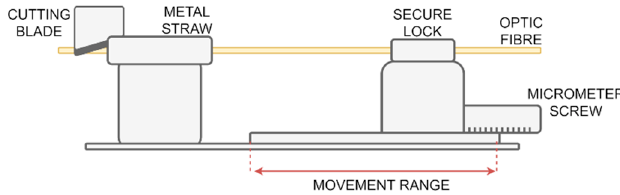
Figure 7. Experimental setup of the wearing simulation diagram.